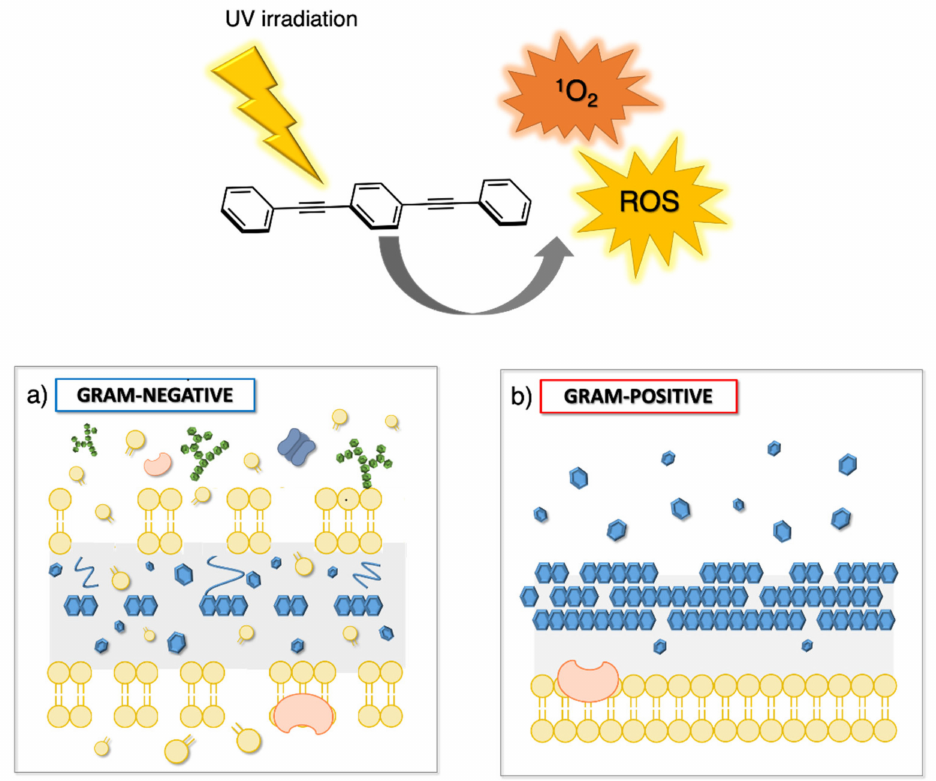
Figure 9. Schematic representation of the killing mechanism of Gram-negative and Gram-positive by